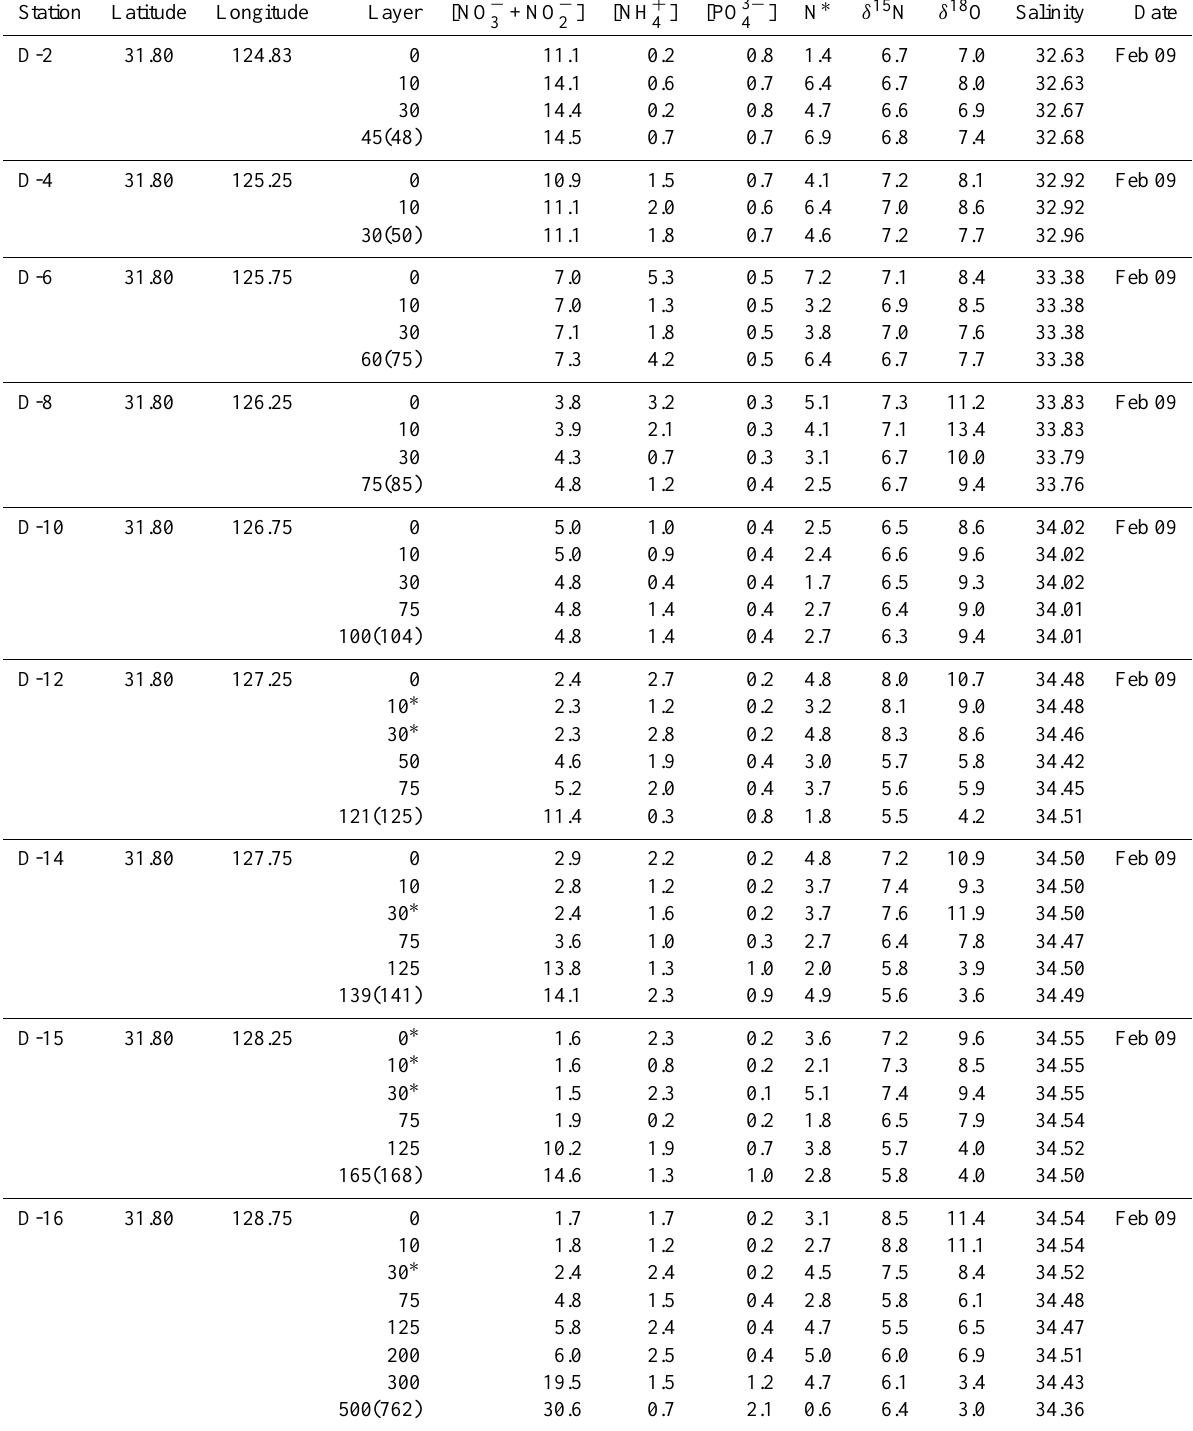
Table 1. Nitrate concentration and δ 15 N and δ 18 O in nitrate at each layer of the sampling stations in February 2009. The depth (m) in parentheses indicates the water depth, and the layers with asterisks are the chlorophyll maximum.